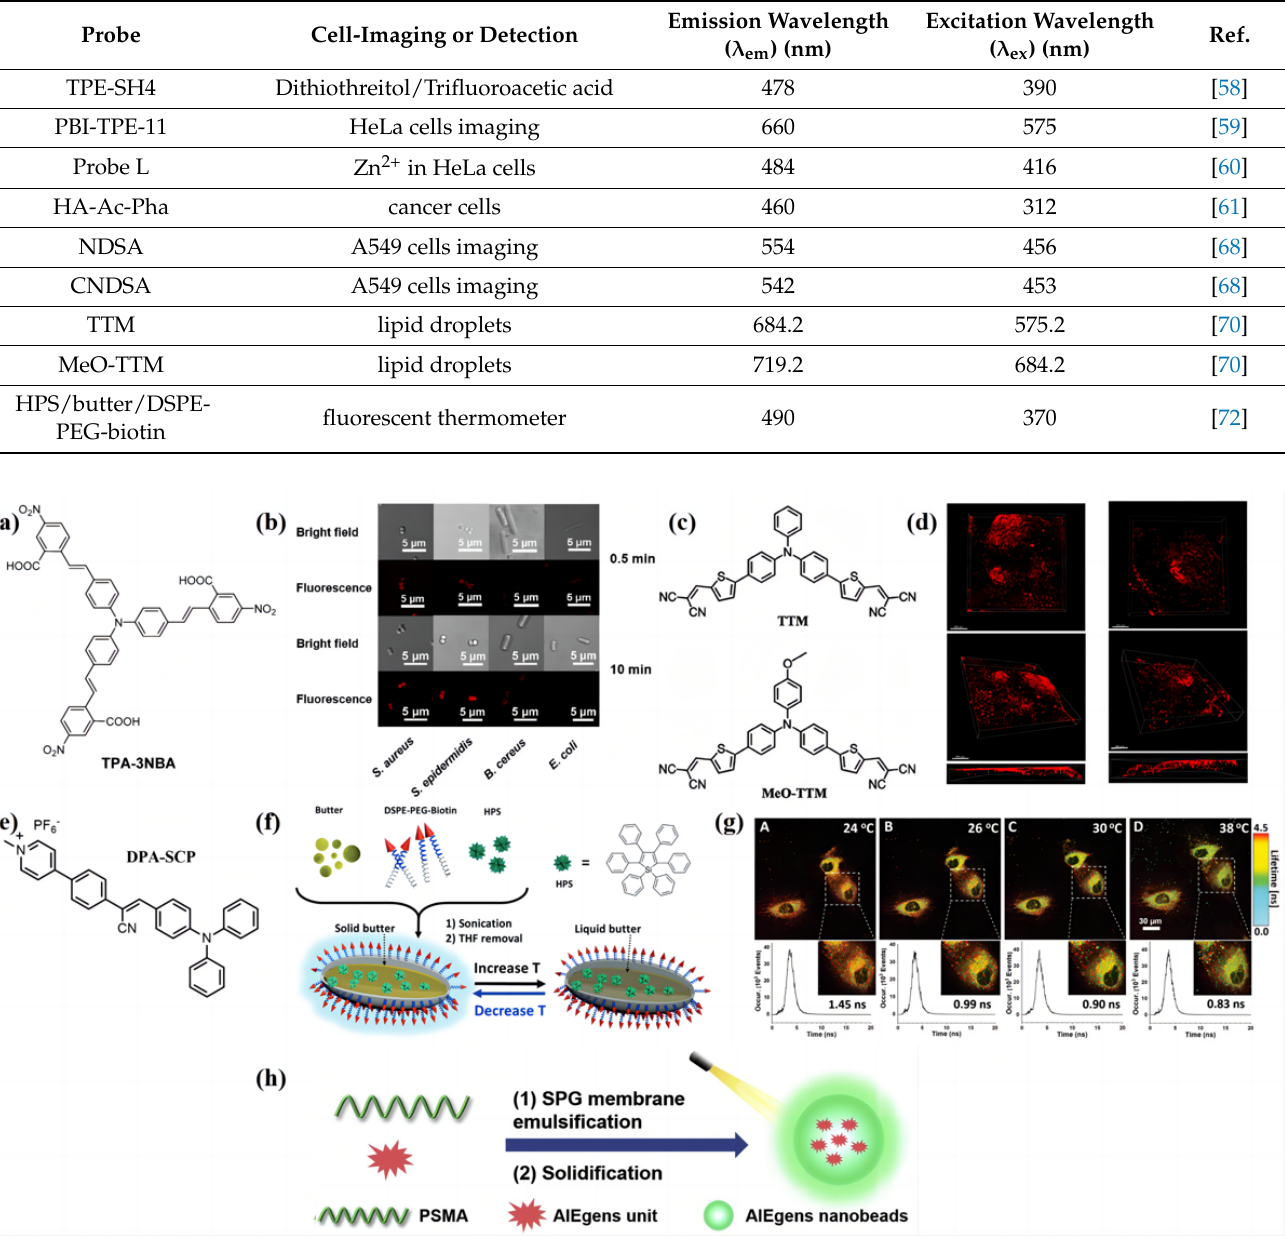
Figure 5. ( a ) Molecular structure of TPA ‐ 3NBA. ( b ) Confocal laser scanning microscopy (CLSM) images of S. aureus , S. epidermidis , B. cereus, and E. coli after 0.5 min or 10 min of incubation with TPA ‐ 3NBA. Adapted with permission from [69]. ( c ) Molecular structures of TTM and MeO ‐ TTM. ( d ) CLSM images of atherosclerotic plaques; 3D images with different view angles of TTM ‐ stained (left) and MeO ‐ TTM ‐ stained (right) atherosclerotic plaques. Scale bar = 200 μ m. Adapted with